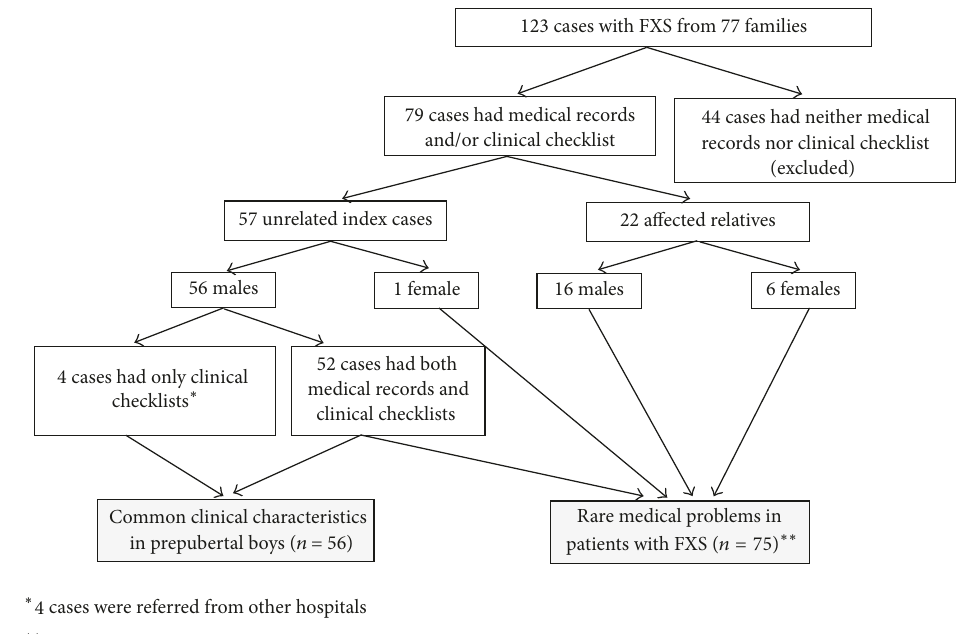
Figure 1: Diagram depicting summary of study